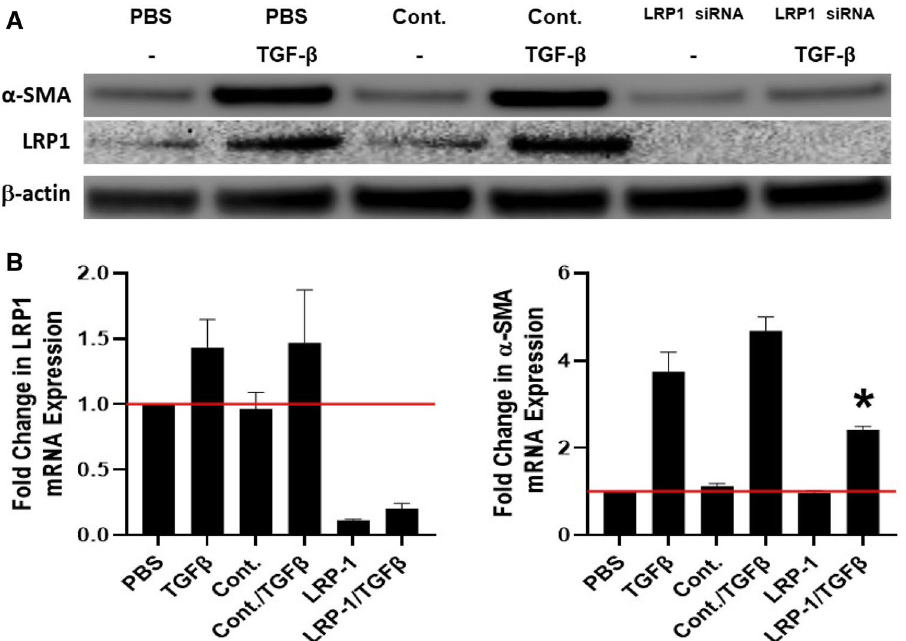
Figure 4. uPA down-regulation blocks TGF-β induced MesoMT. Untransfected, control siRNA and uPA siRNA transfected cells were serum-starved for 24 h. ( A ) Cell lysates were then probed for urokinase antigen by ELISA. Serum starved untransfected, control siRNA and uPA siRNA transfected cells were treated with PBS or TGF-β for 24 h (RNA analyses) and 48 h (protein analyses). ( B ) Cell lysates were resolved by SDS-PAGE and immunoblotted for α-SMA, uPAR and phosphorylated Akt via Western blot. Akt was the loading control. Image is representative of three independent experiments. ( C ) Total RNA was isolated from untransfected, control siRNA and uPA siRNA transfected cells that had been treated with TGF-β for 24 h. Changes in α-SMA and uPA mRNA levels were determined by qPCR analyses. GUSB was used as the reference gene. Data represents the mean of three independent experiments. *denotes p < 0.05 compared to TGF-β treated HPMCs. HPMCs were serum-starved in the presence or absence of the uPA inhibitor, BC11, for 24 h. Cells were then treated with TGF-β in the presence and absence of BC11 for 48 h. ( D ) Cell lysates and conditioned medias were resolved by SDS page and immunoblotted for α-SMA and Col-1, respectively, via Western blot. β-actin was the loading control. Image is representative of three independent experiments. Graphed data represent n = 3. * denotes a p < 0.05 compared to TGFβ treatment. ( E ) Serum starved untransfected, control siRNA and uPAR siRNA transfected cells were treated with PBS or uPA for 48 h. Cell lysates were resolved by SDS-PAGE and immunoblotted for α-SMA and phosphorylated Akt via Western blot. Akt was the loading control. Image is representative of three independent experiments.